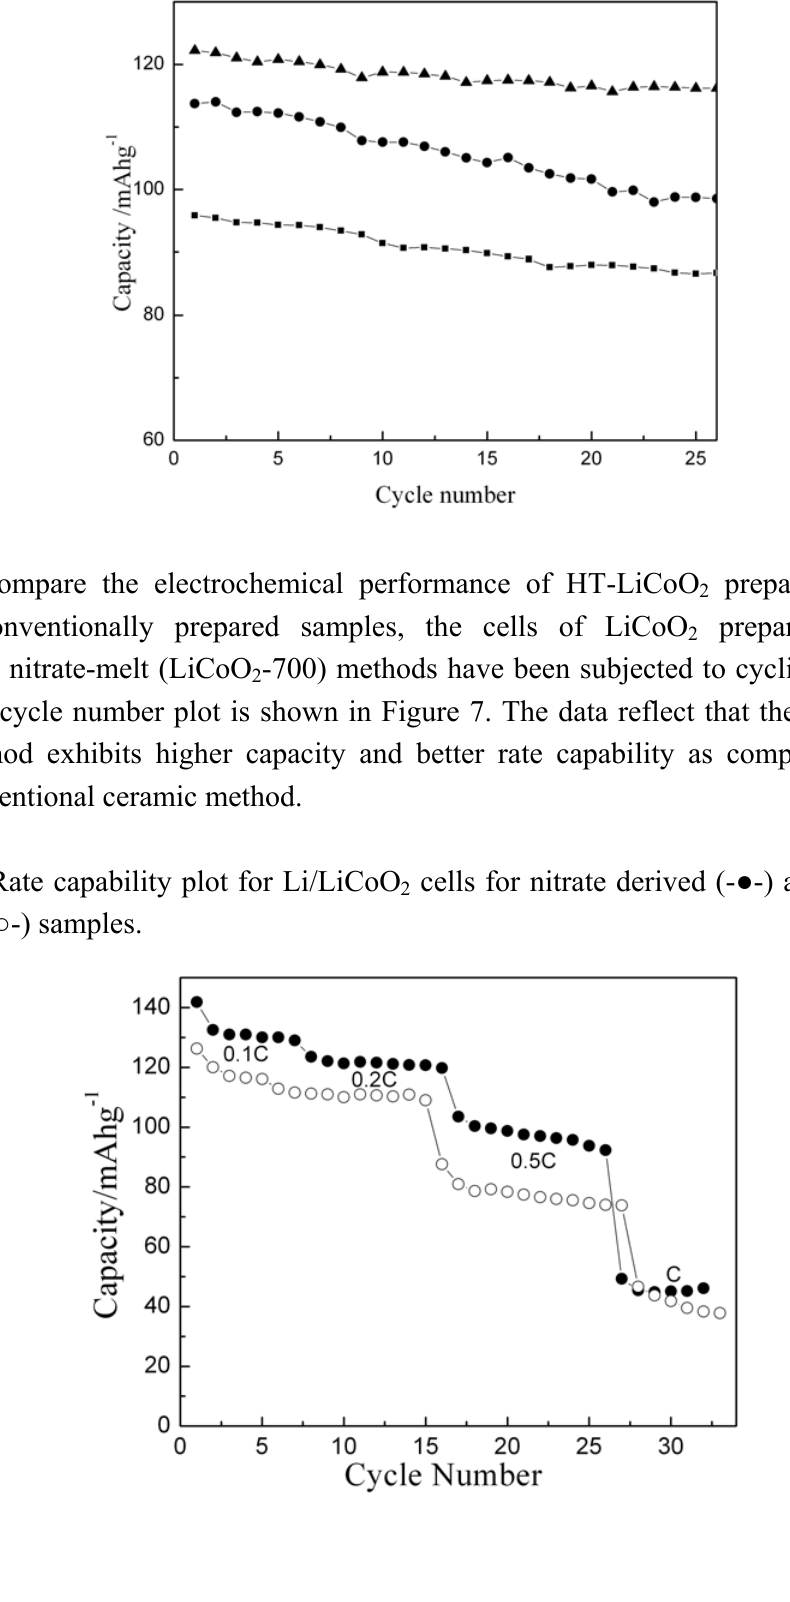
prepared at different temperatures: - ● - 2